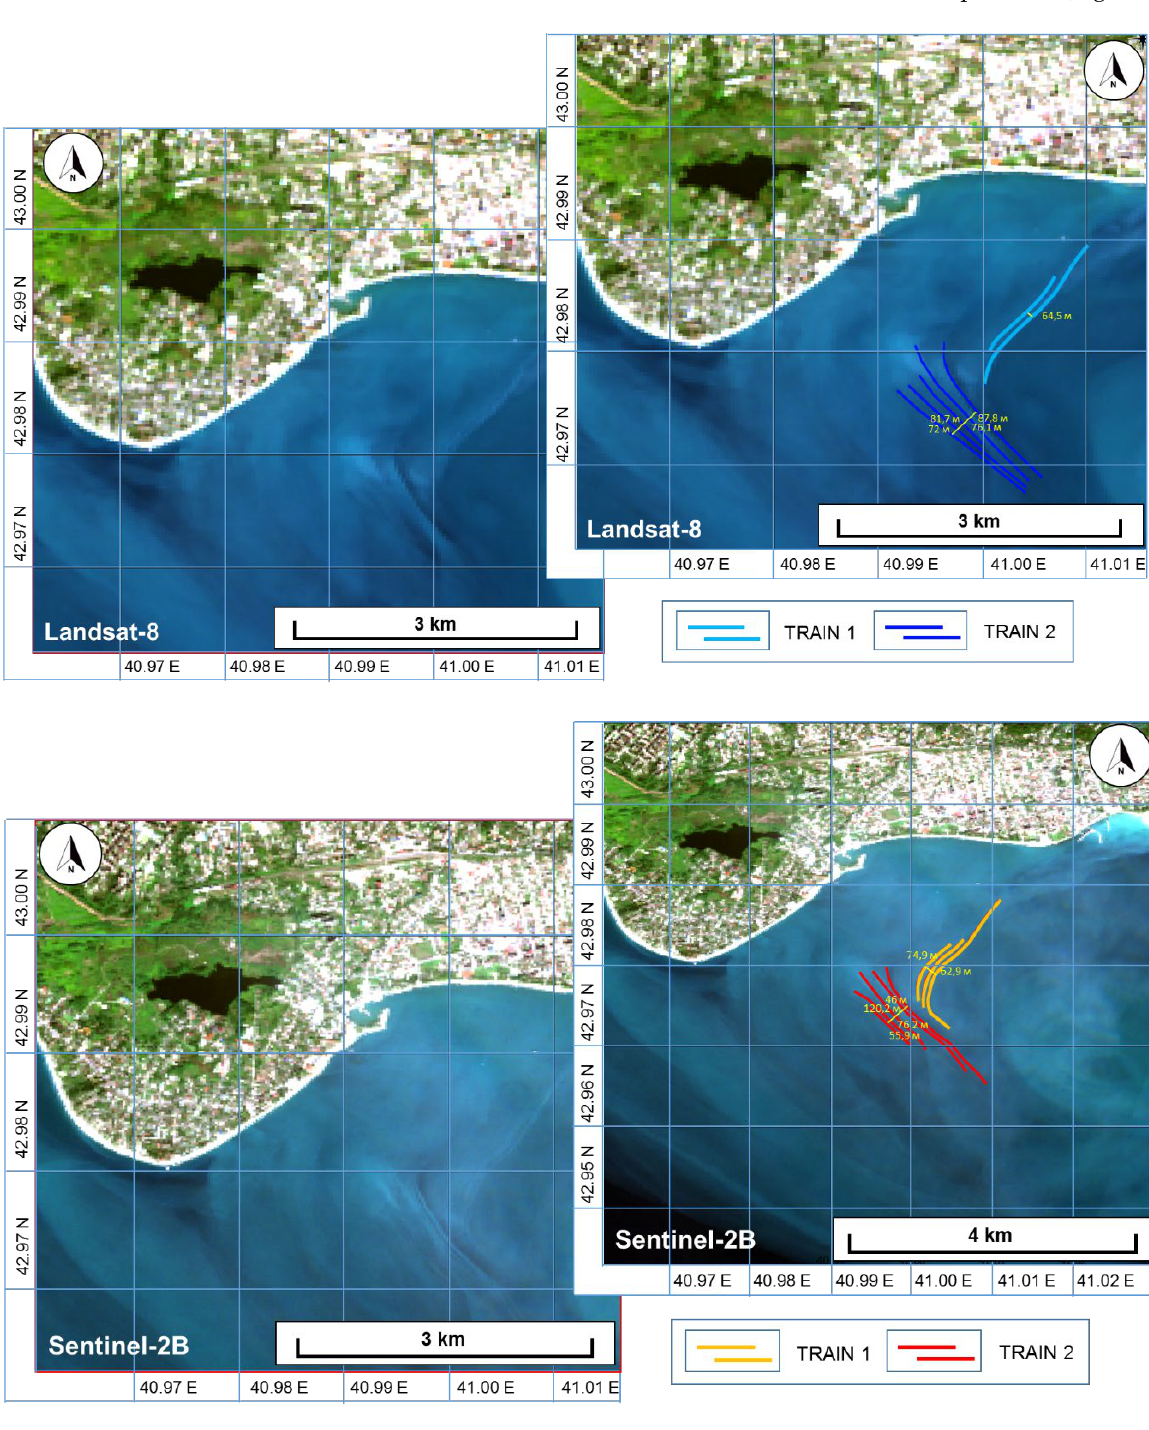
Figure 12. Optical satellite images obtained sequentially with a time interval of ~16 min on 4 October